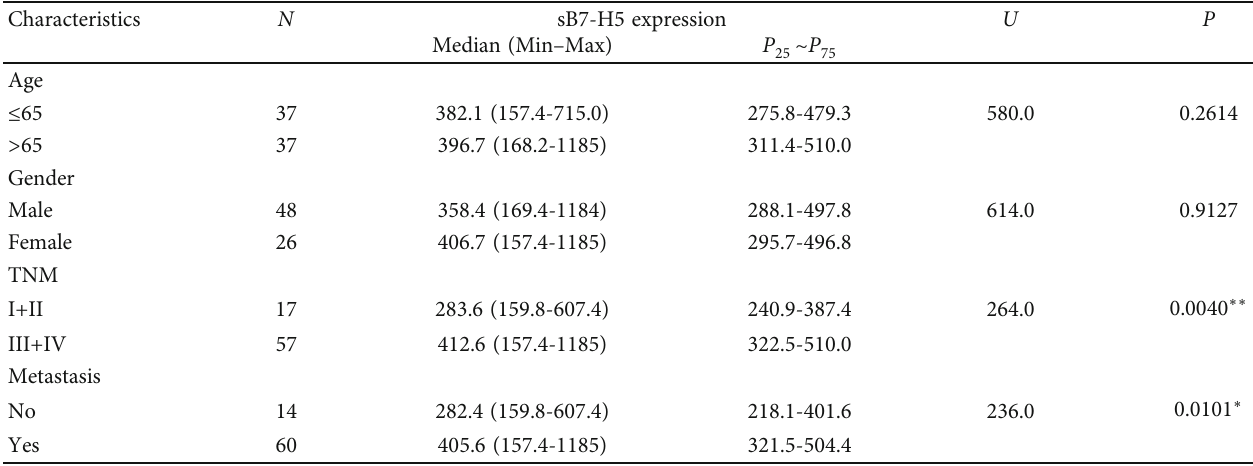
Table 2: The relationship between the levels of sB7-H5 in sera of patients with CRC and clinicopathological characteristics. Characteristics